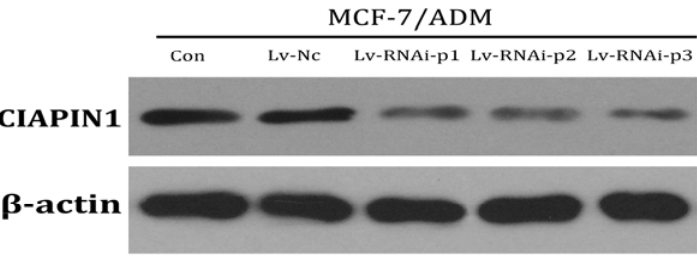
Figure 5. We infected lentiviral expressed vector into MCF7/ADM cells (MOI = 6) and obtained high inhibition efficiency of protein expression (>83%) while the expression lever of target gene had no change in various clone ages.